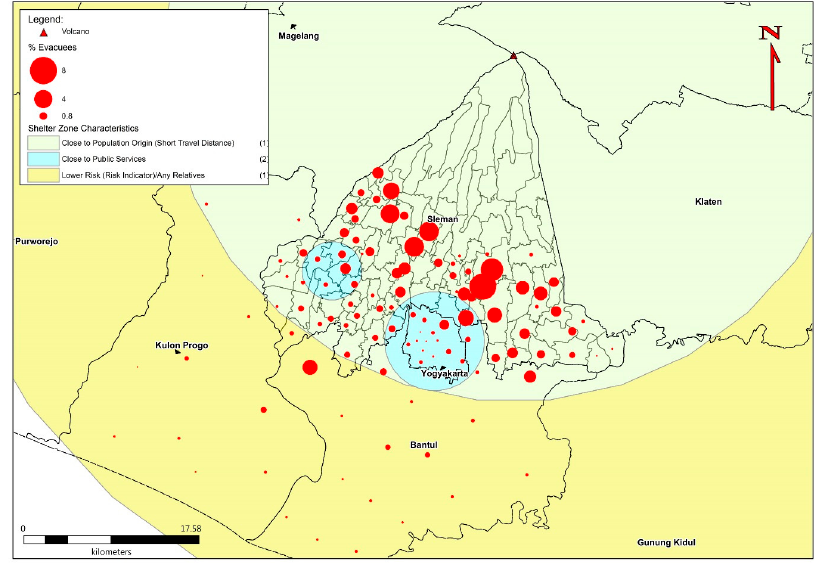
Figure 16. Distribution of evacuees from Sleman in the 2010 Merapi crisis. Source: Geospatial BNPB [104–107], DYMDIS GEGAMA [108]. The shapefile is provided in Supplementary Material— Appendix 11.